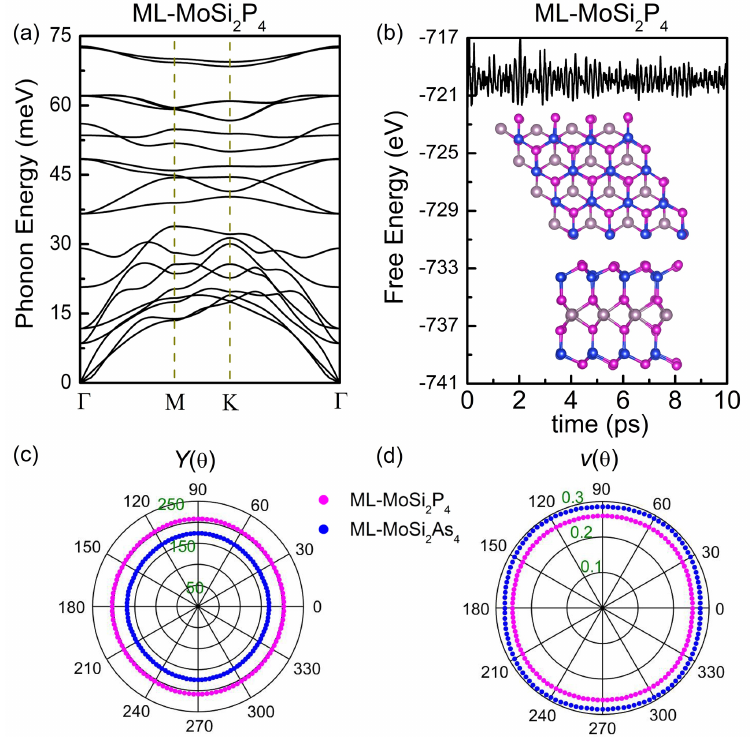
Figure 2. ( a ) Phonon dispersion curves and ( b ) total energy variation at 300 K of monolayer MoSi 2 P 4 . Inset in ( b ) shows the top view and side view of a snapshot at 10 ps. ( c ) Young’s modulus Y ( θ ) and ( d ) Poisson’s ratio ν ( θ ) of monolayer MoSi 2 P 4 (purple curve) and MoSi 2 As 4 (blue curve) along arbitrary in-plane